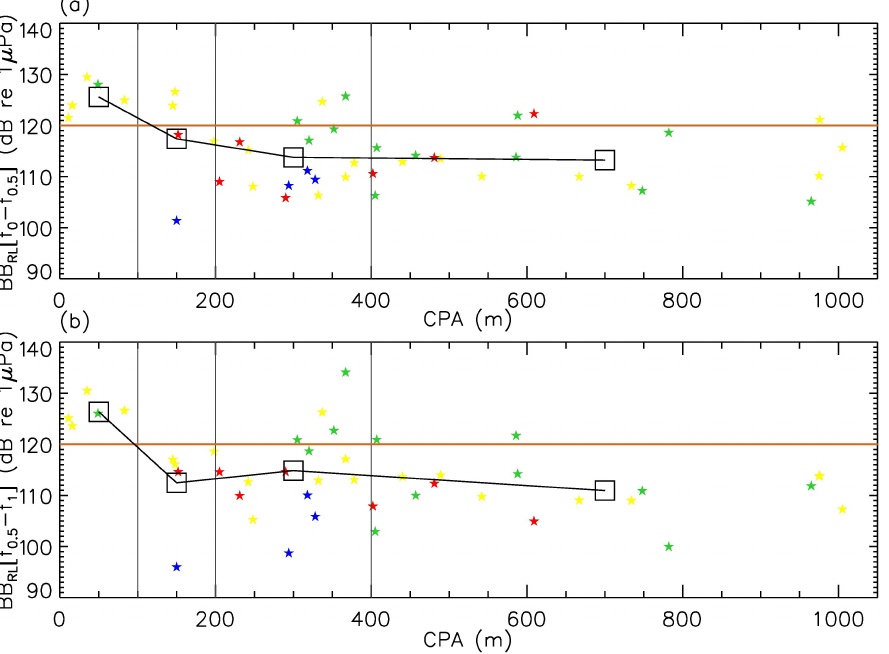
Figure 7. Relationships between CPA distances and broadband received noise levels ( a ): low frequencies, ( b ): mid frequencies. Data were retrieved from Tables 1 and 2. Zodiac TM , speedboats, cruisers, and sailboats are coloured in red, yellow, green, and blue, respectively. Black curves give the average noise level for CPA distances less than 100 m, between 100 and 200 m, between 200 and 400 m, and above 400 m. In both panels, the horizontal brown line indicates the 120 dB re 1 µ Pa behavioural-disturbance threshold (see